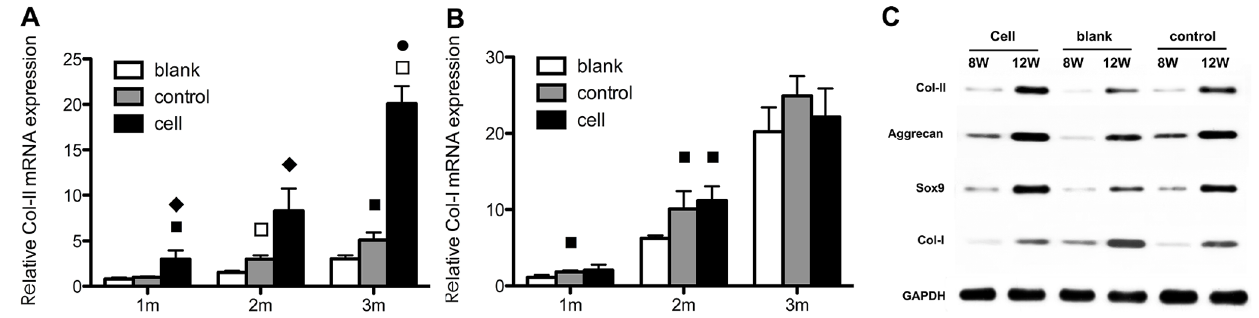
Figure 6. Gene expression and protein levels invivo . Collagen I ( A ) and collagen II ( B ) gene expression levels over 3 months were determined using qRT-PCR, and western blotting was used to evaluate the collagen II, aggrecan, sox9 and collagen I protein levels in the regeneration area ( C ). N The scaffold notably stimulated the expression of the cartilage-related markers, but not collagen I. ¤ Statistically significant difference compared Statistically significant difference compared with the control group ( p , 0.01); & Statistically significant difference with the control group ( p , 0.05); compared with the blank group ( p , 0.05).